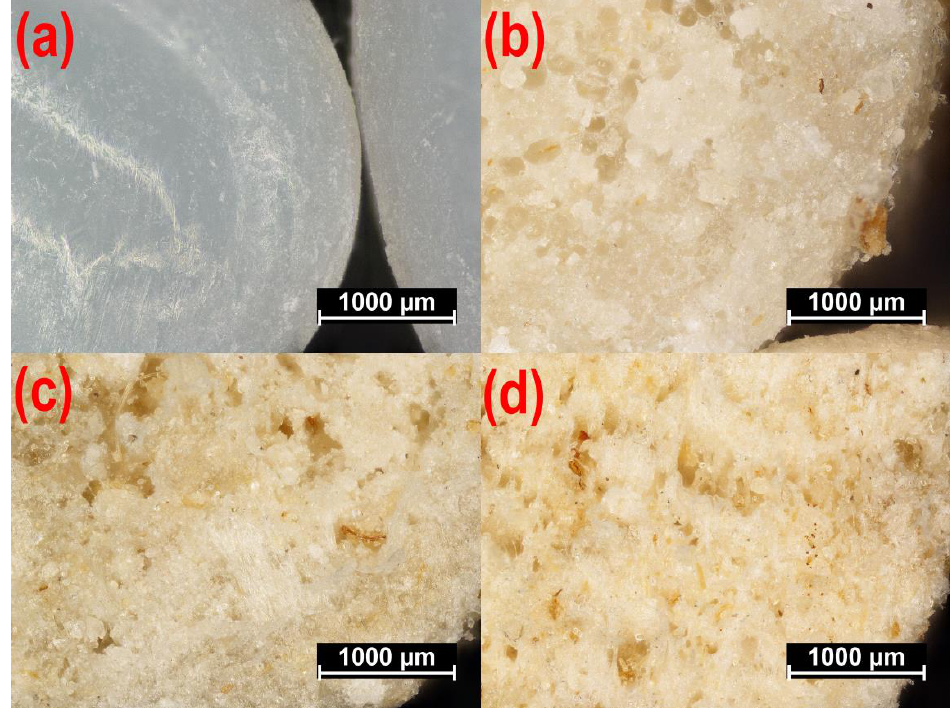
Figure 11. The microscopic images of non-processed poly (butylene succinate) (PBS) ( a ), and the fractures of composite pellets obtained for a screw rotational speed of n = 125 min − 1 and a bran content of ( b ) u = 10 wt.%, ( c ) u = 30 wt.%, ( d ) u = 50 wt.%.